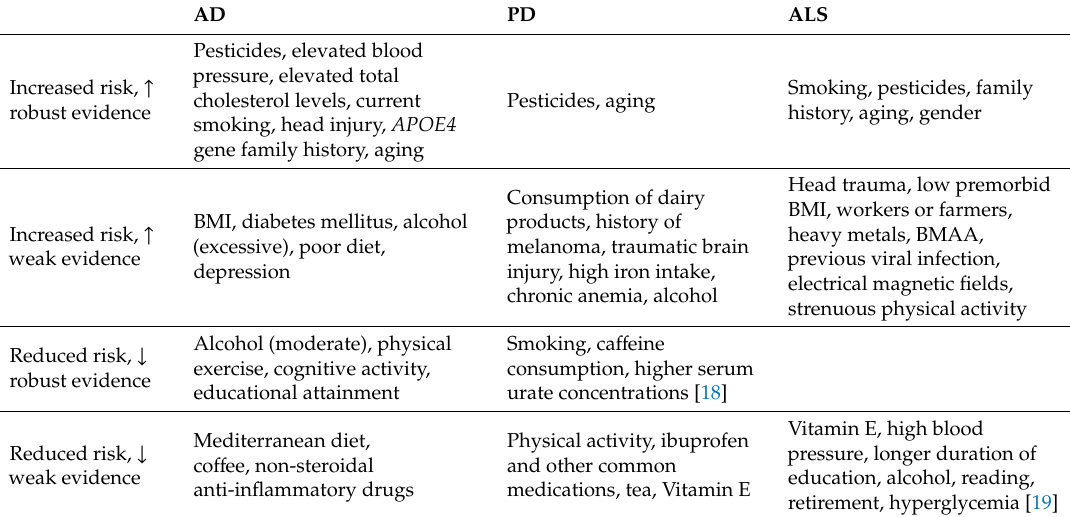
Table 1. Important risk factors for Alzheimer’s disease (AD), Parkinson’s disease (PD) and Amyotrophic lateral sclerosis